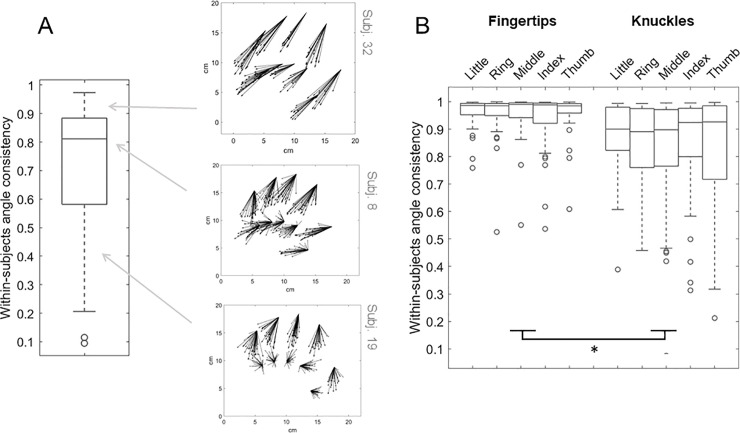
A) The distribution of the within-subjects angle consistency is represented in a box-and-whiskers plot. The error vectors of three exemplificative participants are depicted. B) The within-subjects angle consistency for each landmark is represented through box-and-whiskers plots. The angle consistency is significantly higher for fingertips compared to knuckles, as detected by the Generalized Linear Model (main effect of type) and signaled by the asterisk.